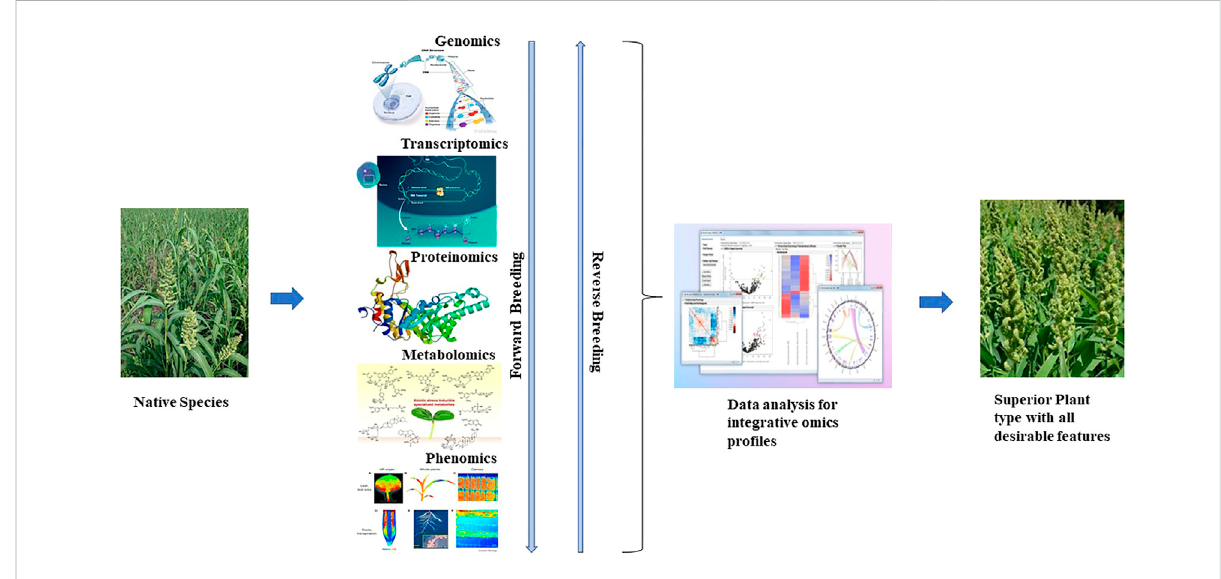
Flow of multi-omics in rapid breeding